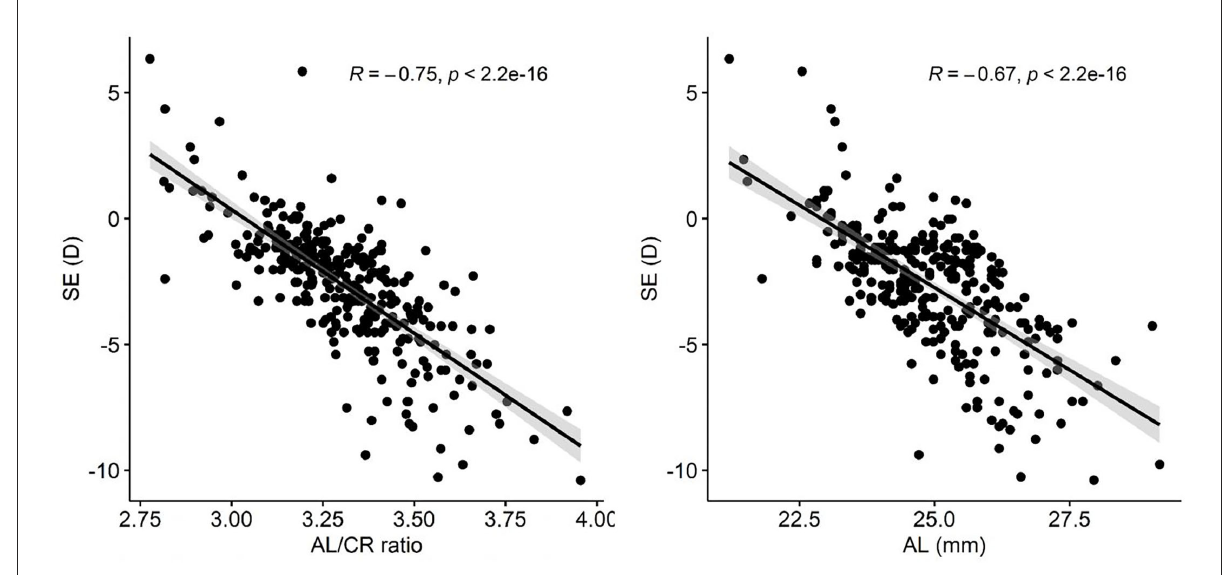
FIGURE2 The correlation analysis between SE, AL, and AL/CR ratio. SE, spherical equivalent; AL, axial length; AL/CR ratio, axial length/corneal radius ratio; R, Pearson correlation coefficient; D, diopter.